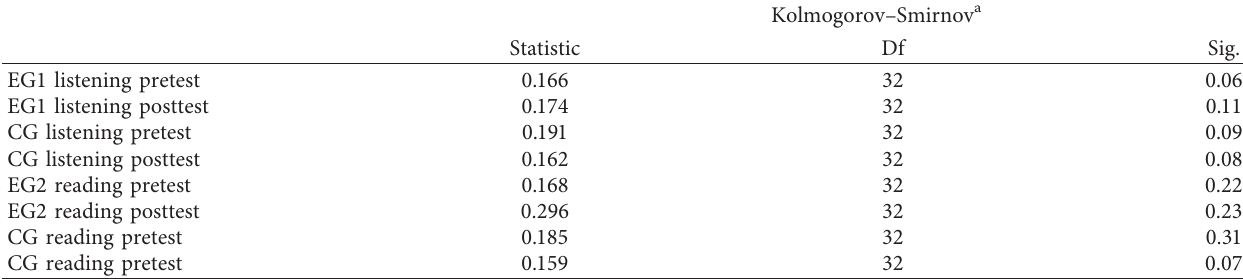
Table 1: Normality test for the scores of the pretest and posttest.